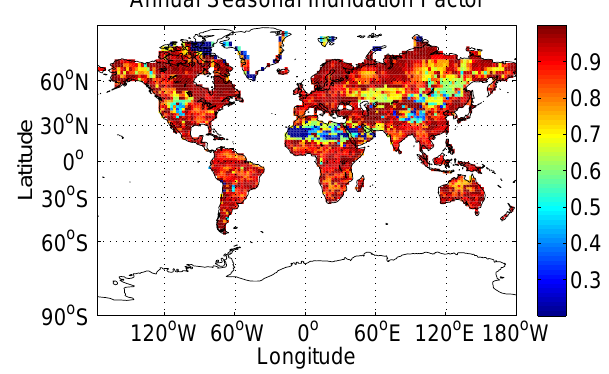
Fig. B1. CH 4 flux-weighted, annual seasonal inundation factor (Eqs. 2 and 3). The global average is